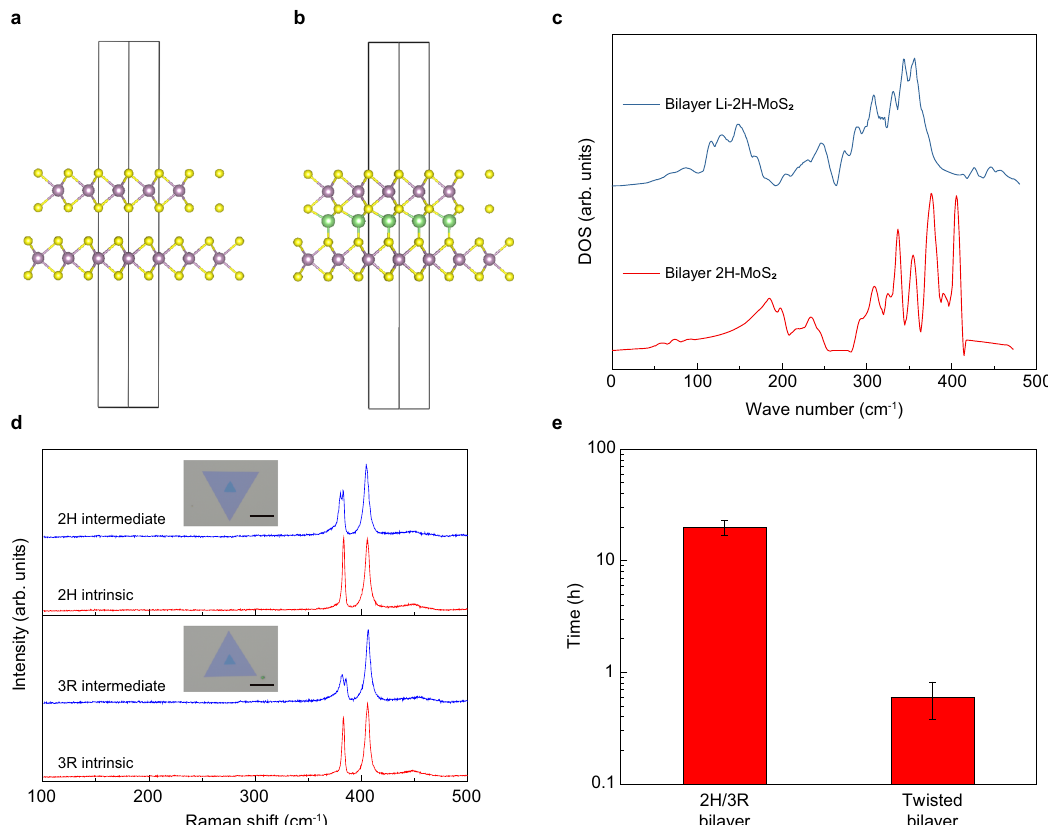
Fig. 5 The intermediate state of untwisted bilayers. Schematic illustration of bilayer 2H-MoS 2 ( a ) and fully intercalated bilayer 2H-MoS 2 ( b ). c The calculated phonon DOS of the structure in a and b. d CVD grown bilayer 2H and 3R MoS 2 , and the corresponding Raman spectra in the intrinsic and intermediate state (scale bar: 10 μ m). e The intercalation time required for phase transition of CVD grown 2H/3R bilayer MoS 2 and transferred twisted bilayer MoS 2 . The error bars are standard deviations based on three samples for each